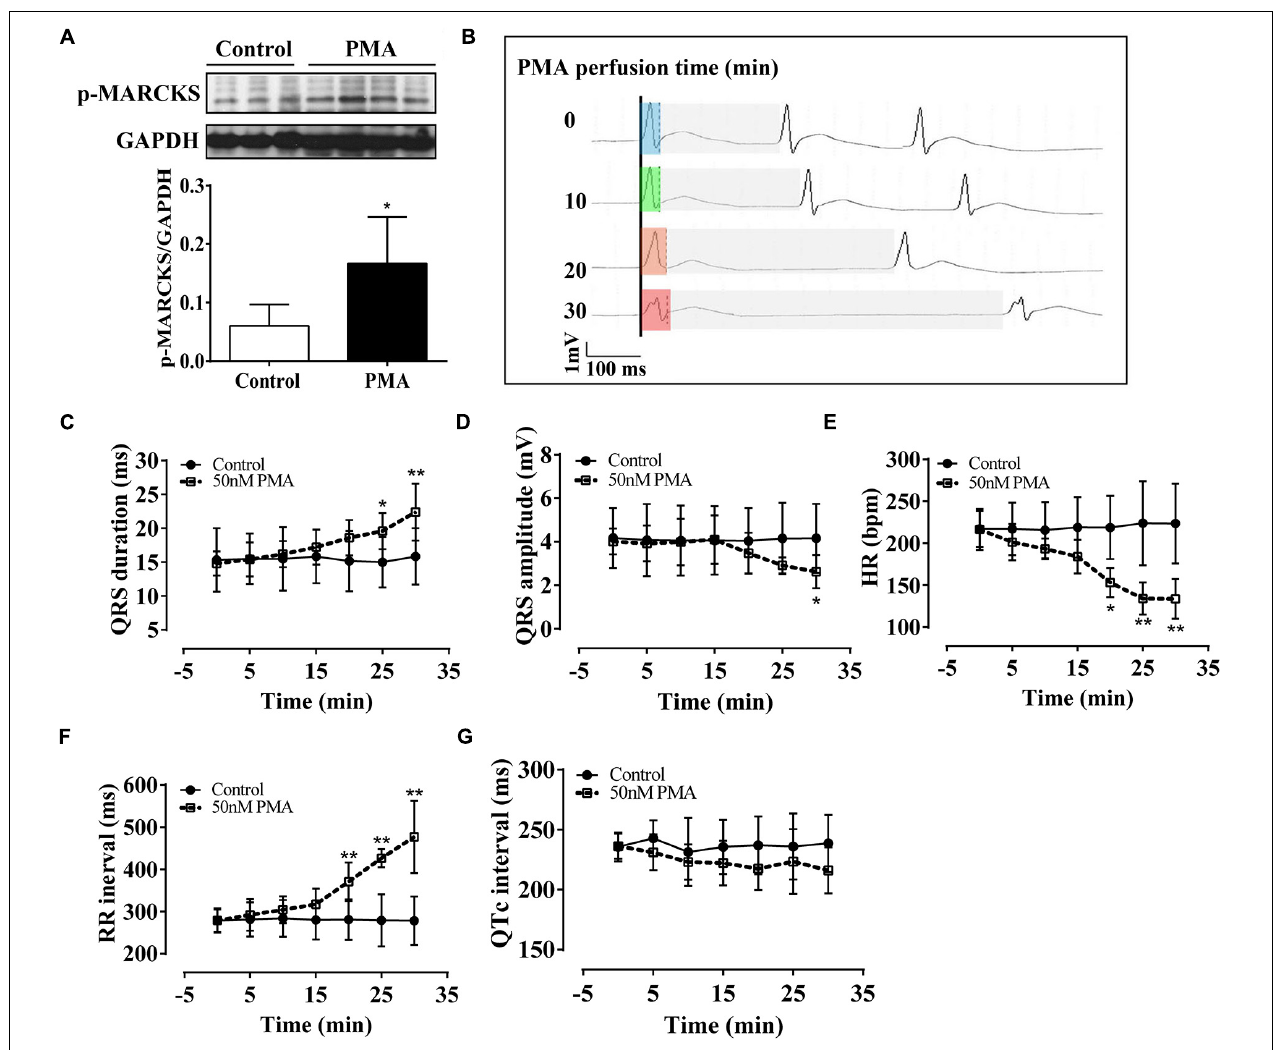
FIGURE 1 | Phorbol-12-myristate-13-acetate (PMA) perfusion induced prolongation and low amplitude of the QRS complex in isolated normal rat hearts. The control hearts were perfused with the Krebs–Henseleit (KH) buffer solution. (A) Western blot analysis showing that PMA perfusion (50 nm) activated phospho-myristoylated alanine-rich C kinase substrate (MARCKS) protein. (B) Representative ECG recording in lead II showed QRS prolongation of the isolated hearts after PMA perfusion for 0, 10, 20, and 30 min. Light blue box: QRS duration of isolated heart after stabilization; light green box: QRS duration of isolated heart after 10-min of perfusion; light orange box: QRS duration of isolated heart after 20-min of perfusion; light red box: QRS duration of isolated heart after 30-min of perfusion; light gray box: RR interval. (C–G) Statistical data of electrocardiography (ECG), QRS duration (C) , QRS amplitude (D) , hear rate (HR) (E) , RR interval (F) , and QTc interval (G) . Error bars represent mean ± SD , n = 5 for each group. * p < 0.05 vs. control, ** p < 0.01 vs.